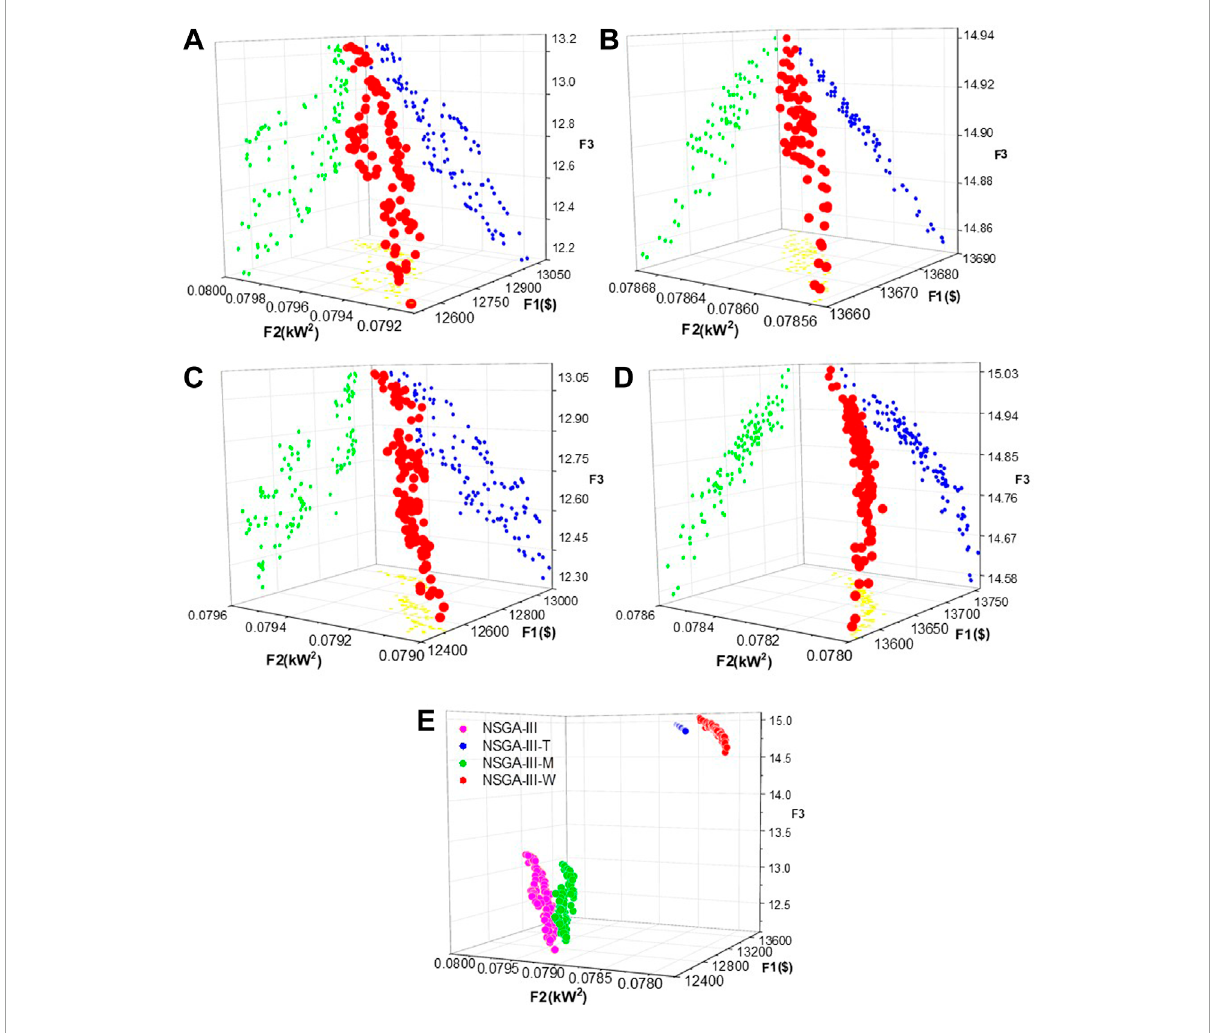
FIGURE 6 Improvement effect of the NSGA-III algorithm: (A) NSGA-III without any improvement; (B) improved NSGA-III with adaptive T-crossover; (C) improved NSGA-III with an adaptive crossover mutation mechanism; (D) NSGA-III-W algorithm with adaptive T cross-crossing operators and adaptive cross-mutation mechanisms; (E) Comparison of all algorithms